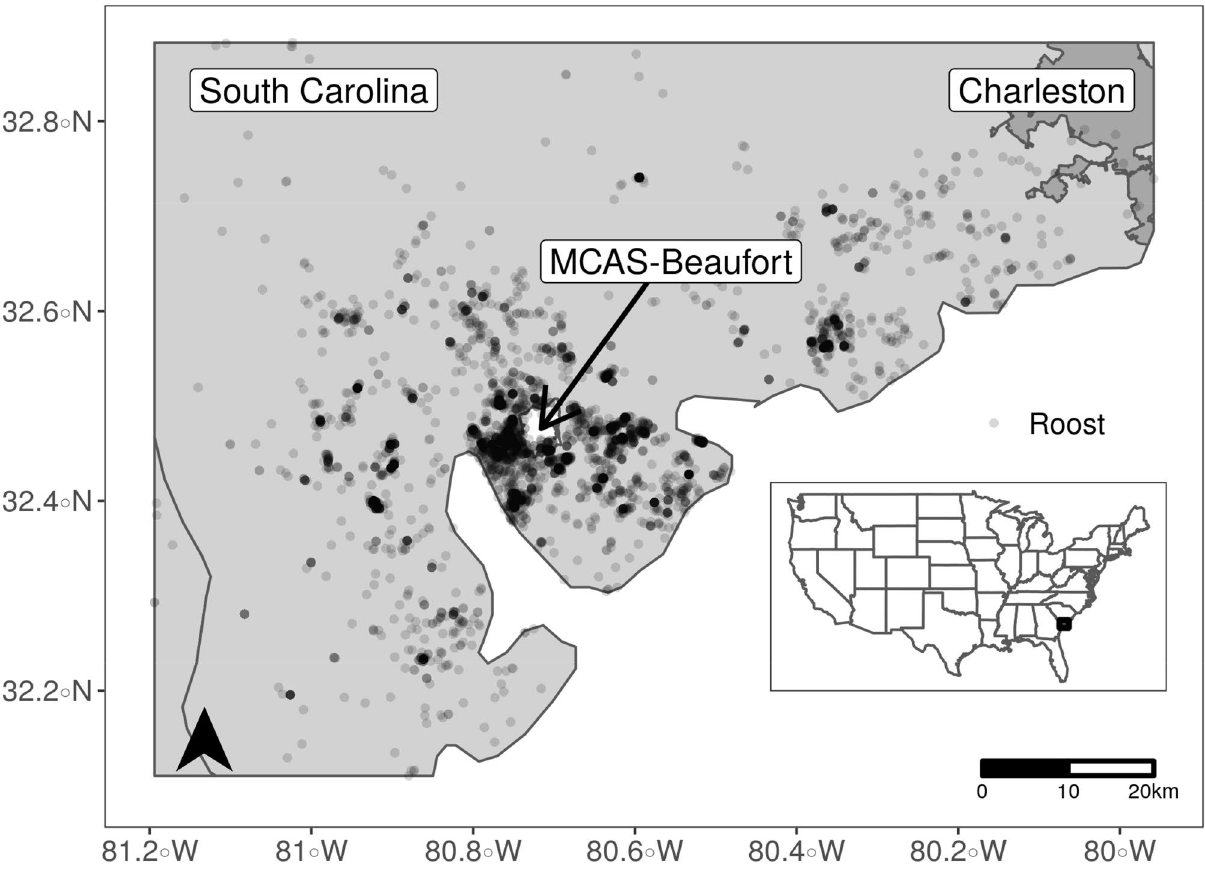
Figure 1. Map of roost locations of 11 black vultures and 7 turkey vultures across southeastern South Carolina, USA. Vultures were tagged at Marine Corps Air Station Beaufort (MCAS-Beaufort) between September 2006 and September 2007. Map was created using packages ggplot2 72 and sf 73 in R version 4.0 51 .